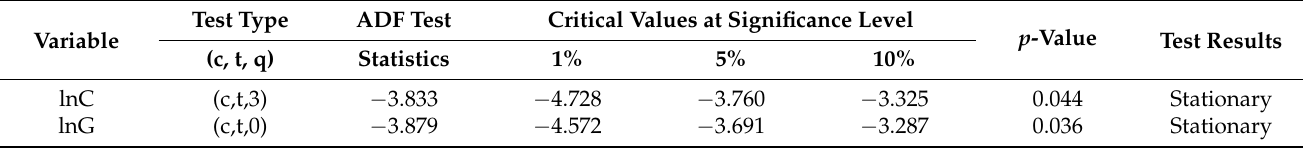
Table 4. Unit root test results.